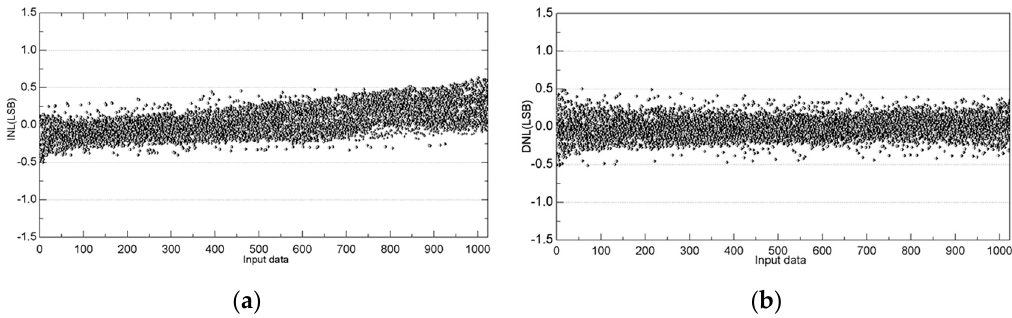
Figure 10. The measurement results of our proposed buffer-reused DAC: ( a ) integral nonlinearity (INL) and ( b ) differential nonlinearity (DNL).